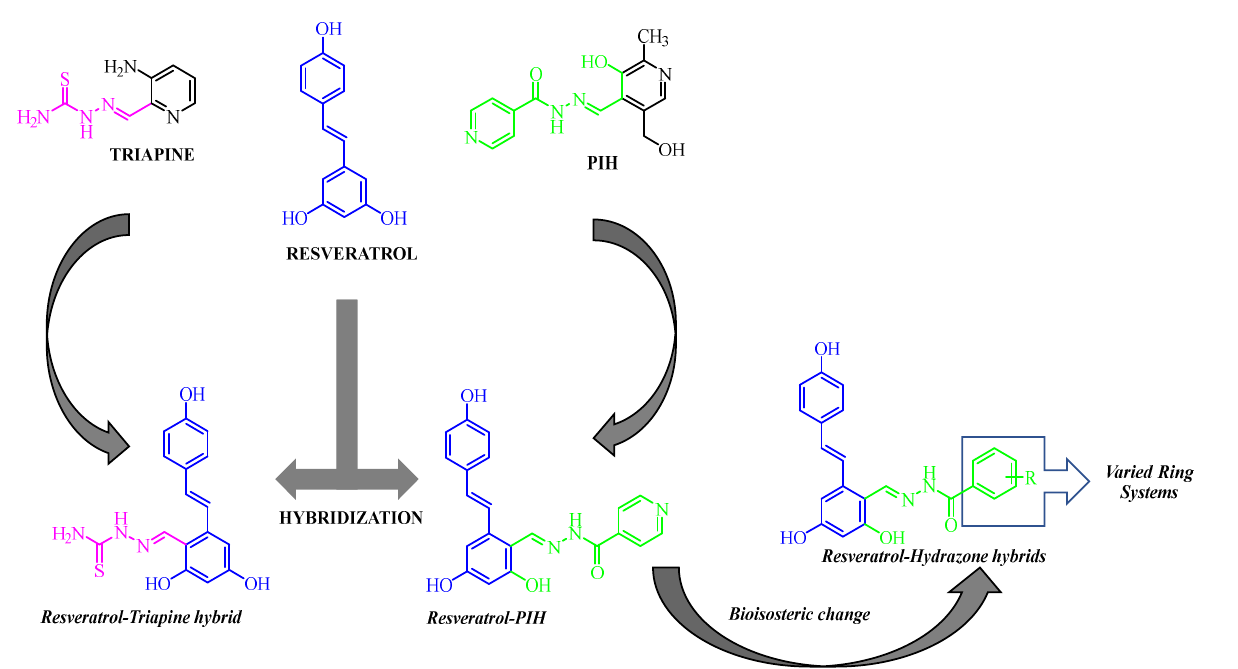
Figure 2. Design of resveratrol/hydrazone hybrids as anticancer agents.